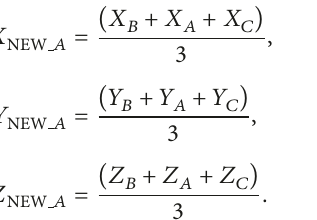
Figure 5: The result of clustering.